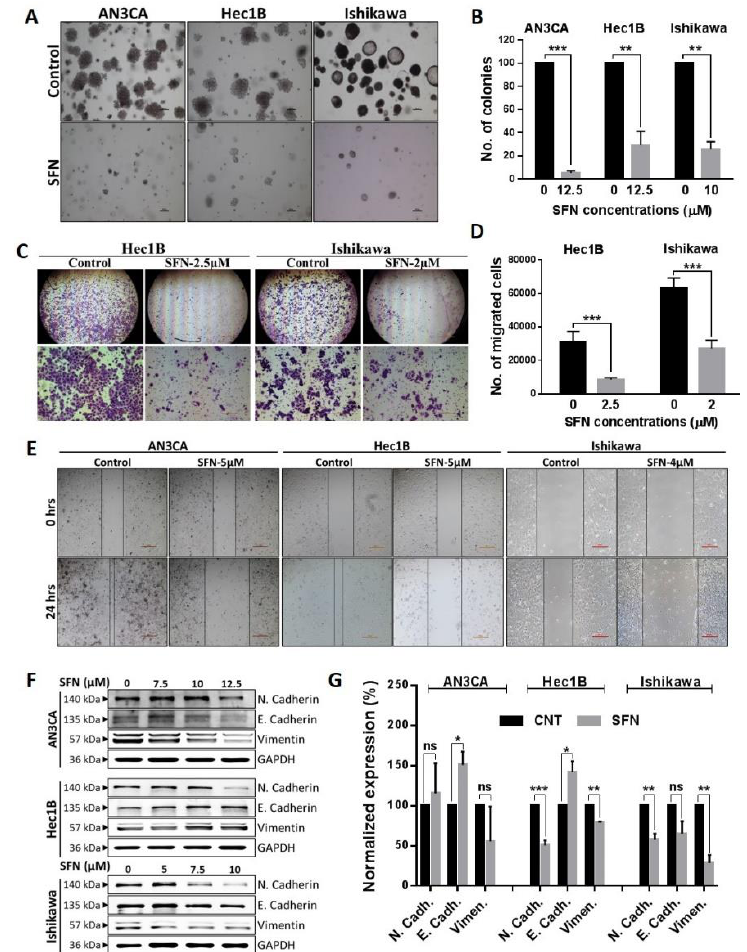
Figure 3. Sulforaphane inhibits endometrial cancer cell clonal growth, migration, and invasion. ( A , B ) A soft-agar colony formation assay was performed in endometrial cells treated with or without